Question: Express in one sentence what the figure is showing.
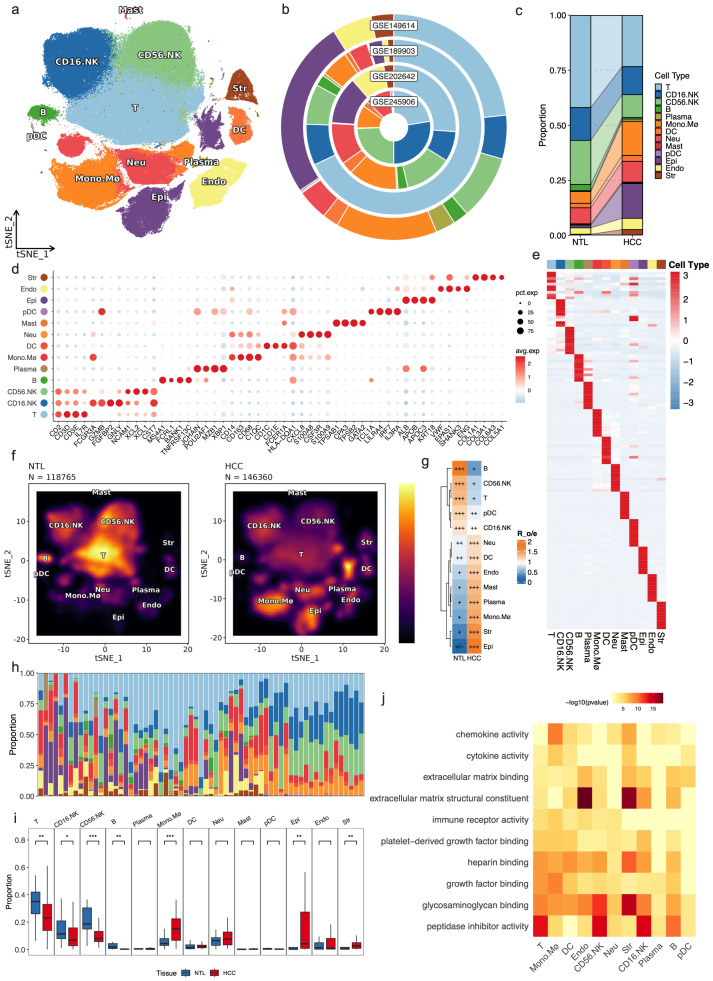
Answer: Single-cell transcriptomic analysis reveals cell type composition and functional remodeling in hepatocellular carcinoma. (A) t-SNE dimensionality reduction showing the integrated cell distribution map. Thirteen major cell types were identified, each represented by a distinct color. (B) Pie chart showing the proportion of different cell types across datasets from different sources. (C) Bar chart showing the proportion of different cell types in tumor and normal groups. (D) Expression profiles of characteristic marker genes across different cell types. (E) Heatmap displaying the top 10 highly expressed genes specific to each cell type, illustrating the transcriptional characteristics of different cell types. (F) Density distribution plot of each cell type in tumor and normal groups, showing differences in cell abundance between groups. (G) Tissue preference of each cluster estimated by the STARTRAC-dist index: +++, Ro/e > 1; ++, 0.8 < Ro/e ≤ 1; +, 0.2 < Ro/e ≤ 0.8; +/-, 0 < Ro/e ≤ 0.2; -, Ro/e = 0. (H) Stacked bar plot showing the proportional distribution of different cell types across samples. (I) Composition ratio of tumor and normal groups within each cell type. (J) Representative GO functional pathways enriched in upregulated DEGs in each cell type. *, P<0.05; **, P<0.01; ***, P<0.001.